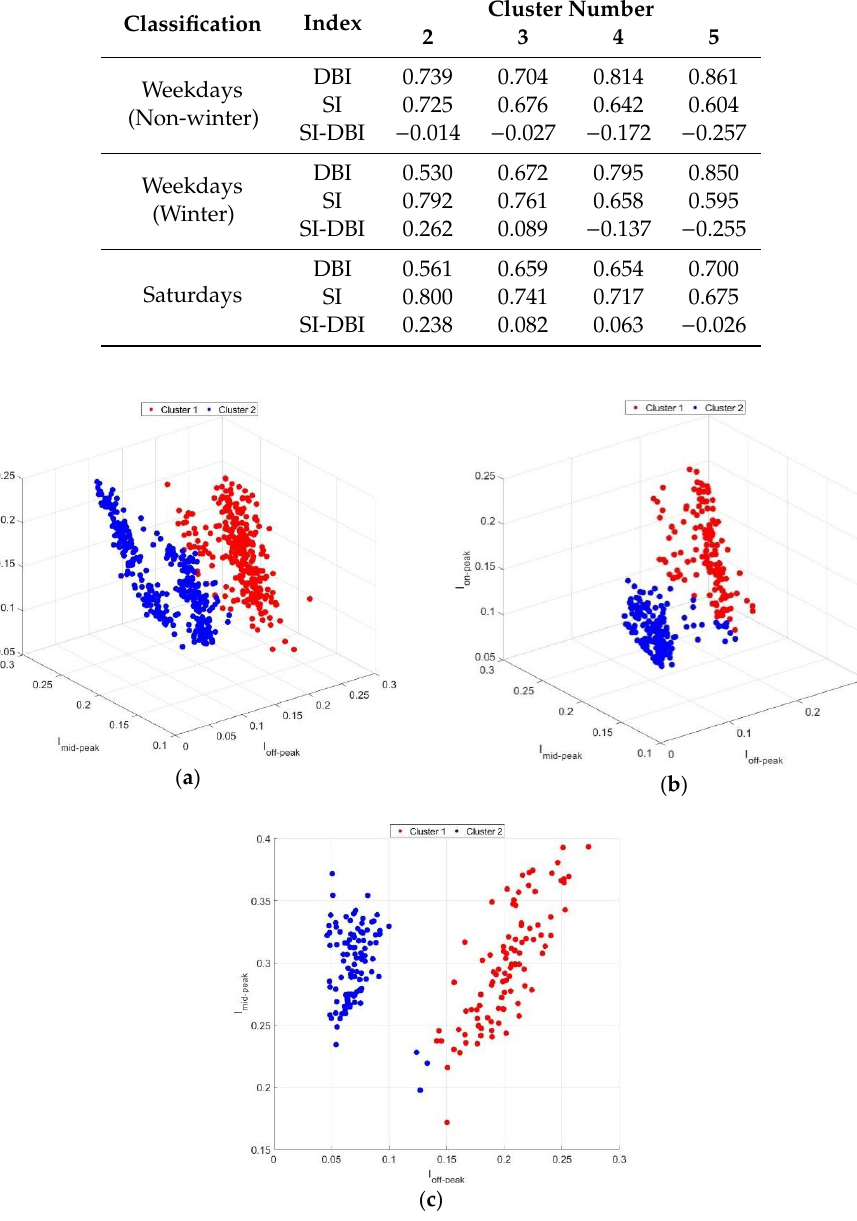
Figure 4. K-means clustering result: ( a ) Weekdays (Non-winter), ( b ) Weekdays (Winter), and ( c ) Saturdays.